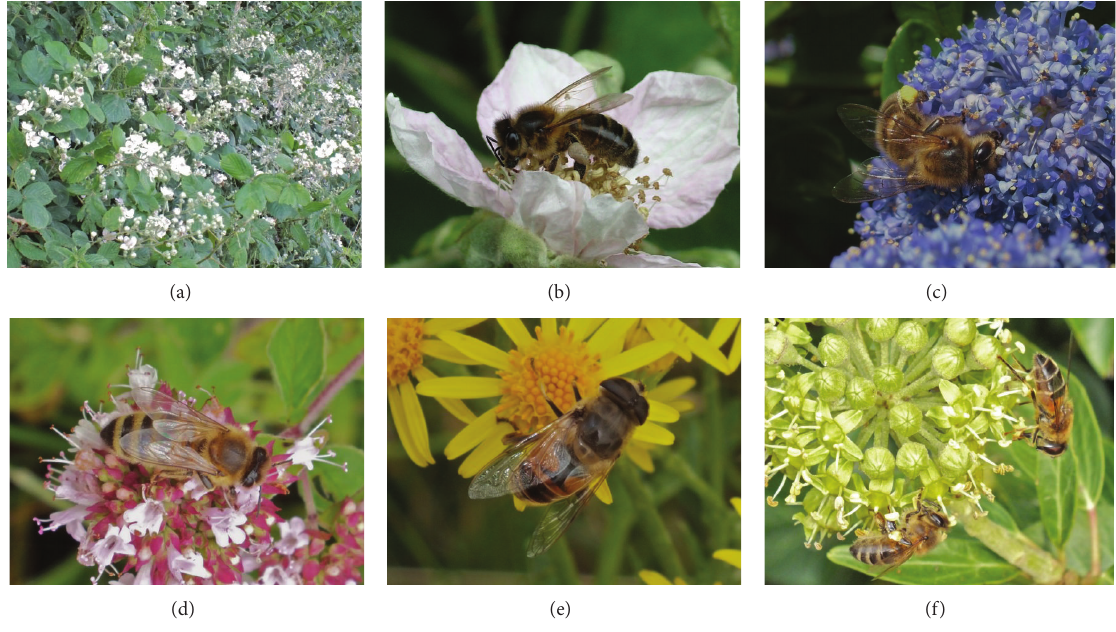
Figure 1: We investigated insect visitation rate on five plant study species: bramble ( Rubus fruticosus (a), (b)), California lilac ( Ceanothus spp. (c)), marjoram ( Origanum vulgare (d)), ragwort ( Jacobaea vulgaris (e)), and ivy ( Hedera helix and H. hibernica spp. (f)). Other than California lilac, a garden shrub, all plants are native to the study area and all five plants were abundant and found in large patches (a). All insects seen are honey bees, with the exception of the similar-sized hoverfly Eristalis spp. on ragwort in (e) and on the right on ivy in (f) (insect on the left in (f) is honey